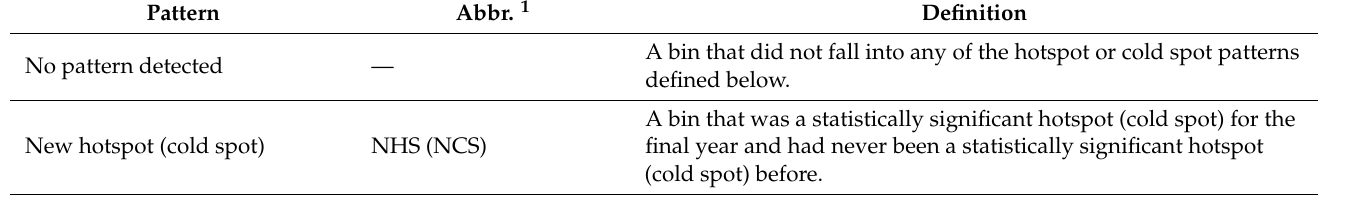
Table 2. The definition of spatiotemporal hotspot patterns by emerging hotspot